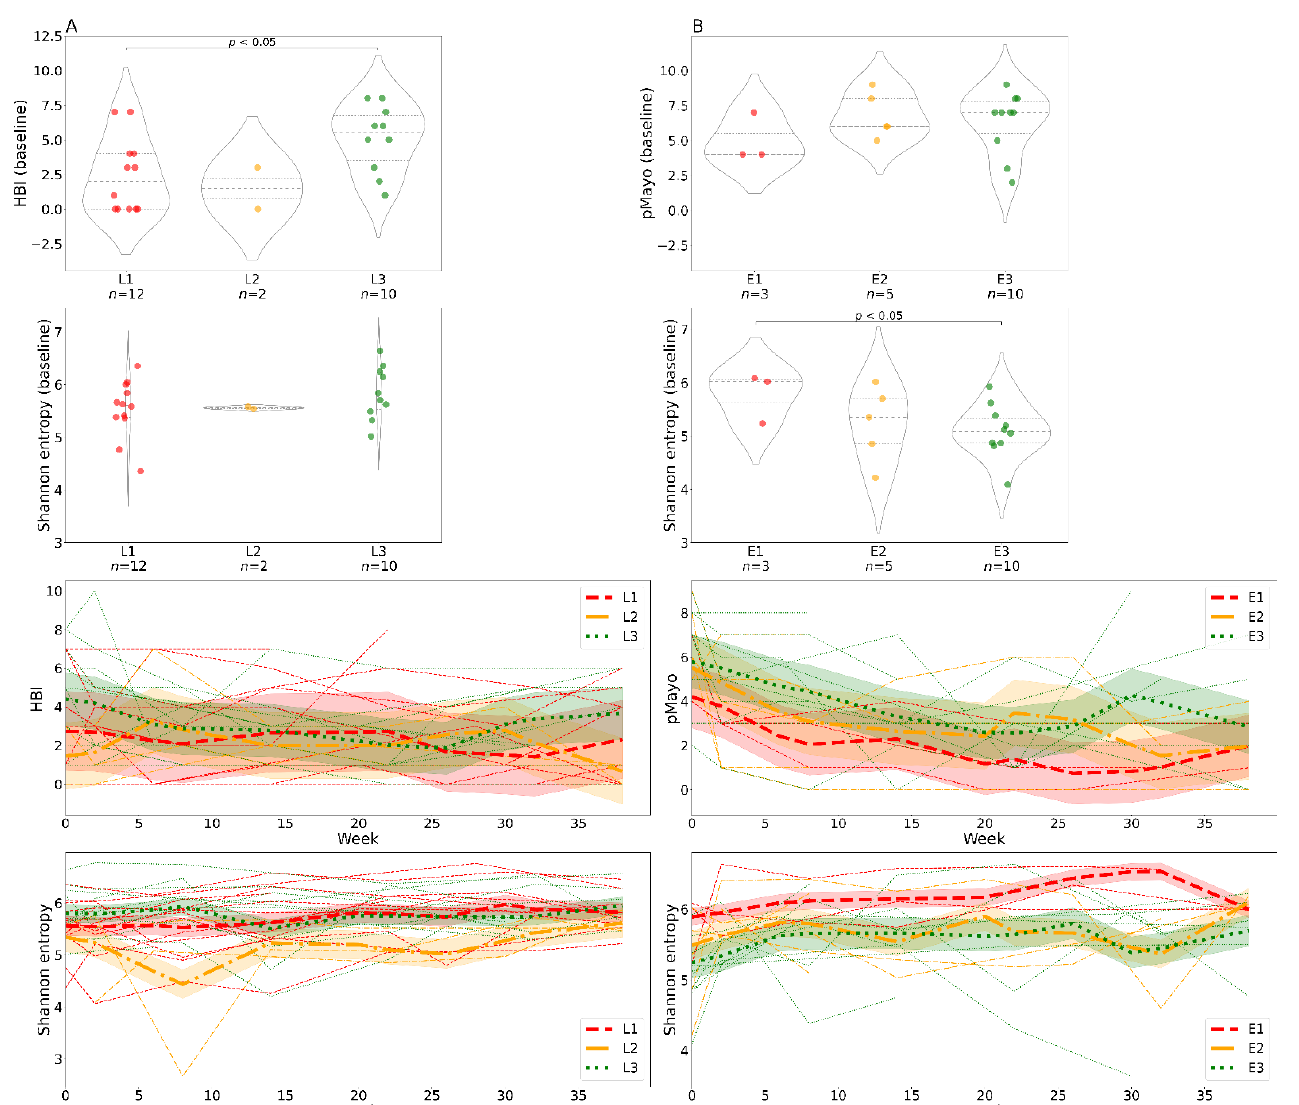
Figure 4. Differences in clinical scores and alpha diversity over time stratified by disease localization. In patients with Crohn’s disease ( A ) and ulcerative colitis ( B ). The violin plots show clinical scores and bacterial alpha diversity at baseline (week 0); the groups represent specific disease localizations. The line charts show changes in clinical scores and bacterial Shannon entropy over time and are color-coded by disease localization. Each line represents one individual; the bold lines represent locally weighted regression with a confidence interval fill. Abbreviations: HBI, Harvey – Bradshaw index; pMayo, partial Mayo score; L1, ileal Crohn’s disease; L2, colonic Crohn’s disease; L3, ileocolonic Crohn’s disease; E1, rectal ulcerative colitis; E2, ulcerative colitis distal to the splenic flexure; E3, ulcerative colitis affecting the whole large intestine and rectum; n , number of samples.